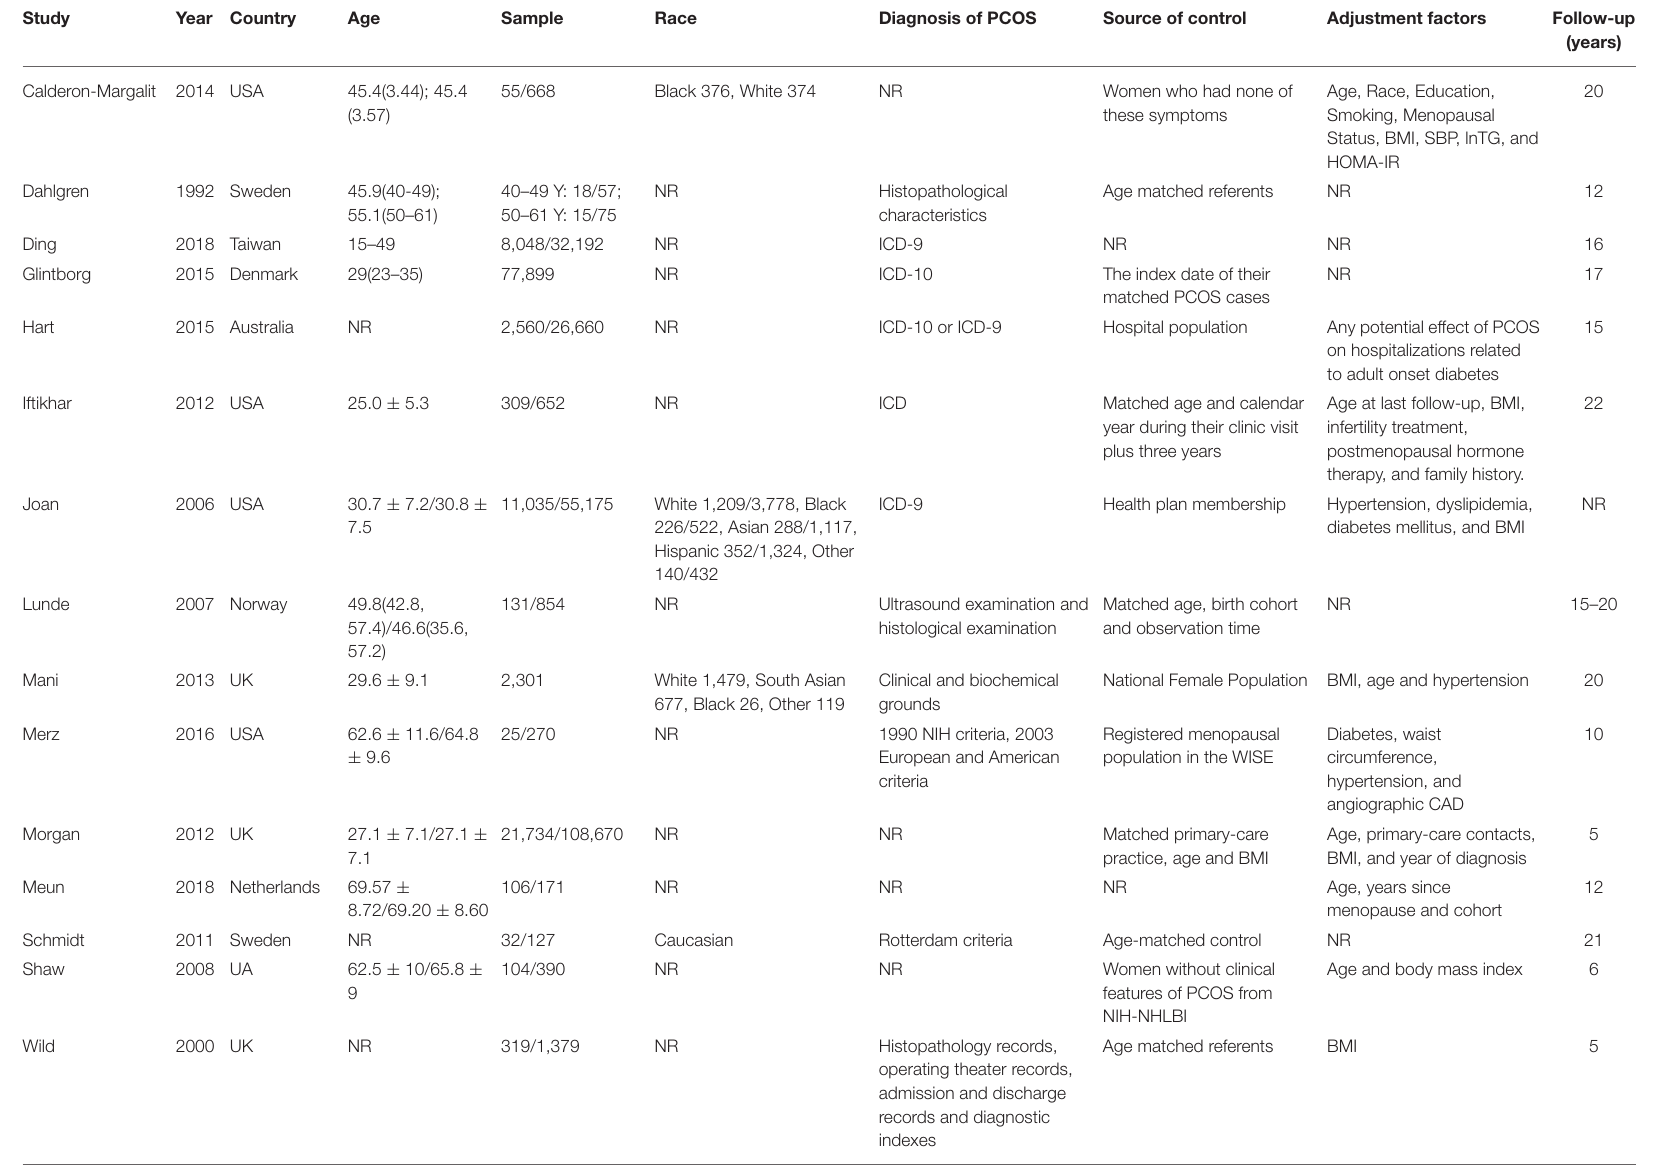
BMI, body mass index; ICD, International Classification of Diseases; NR, Not reported; PCOS, Polycystic ovary